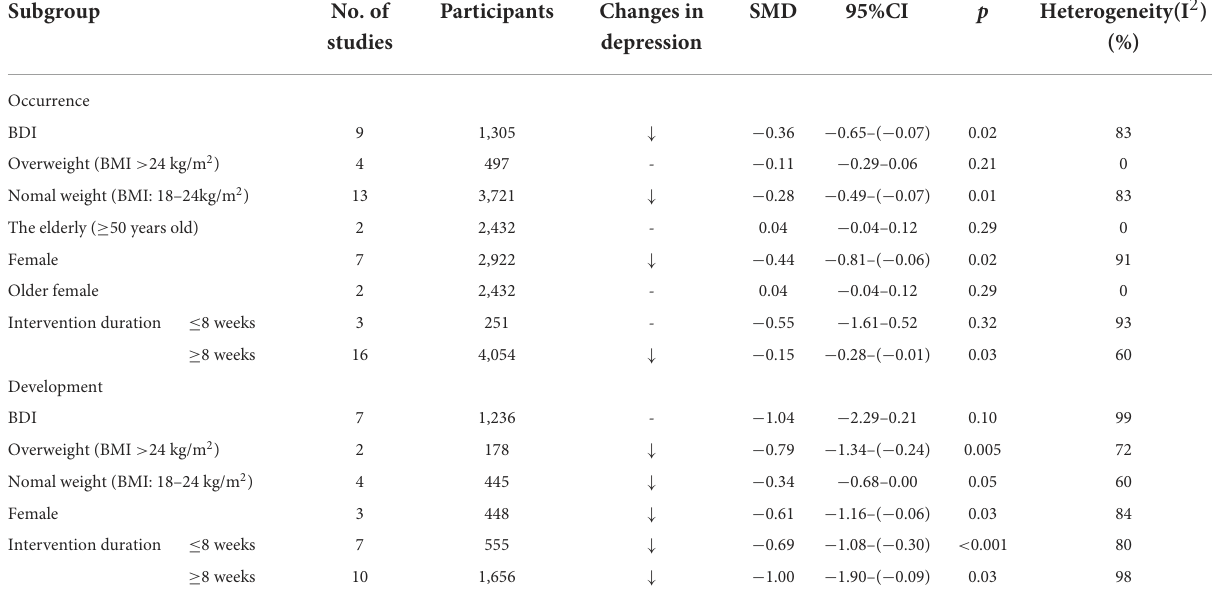
TABLE 3 Subgroup analysis of the correlation between vitamin D and the incidence/prognosis of depression. Subgroup